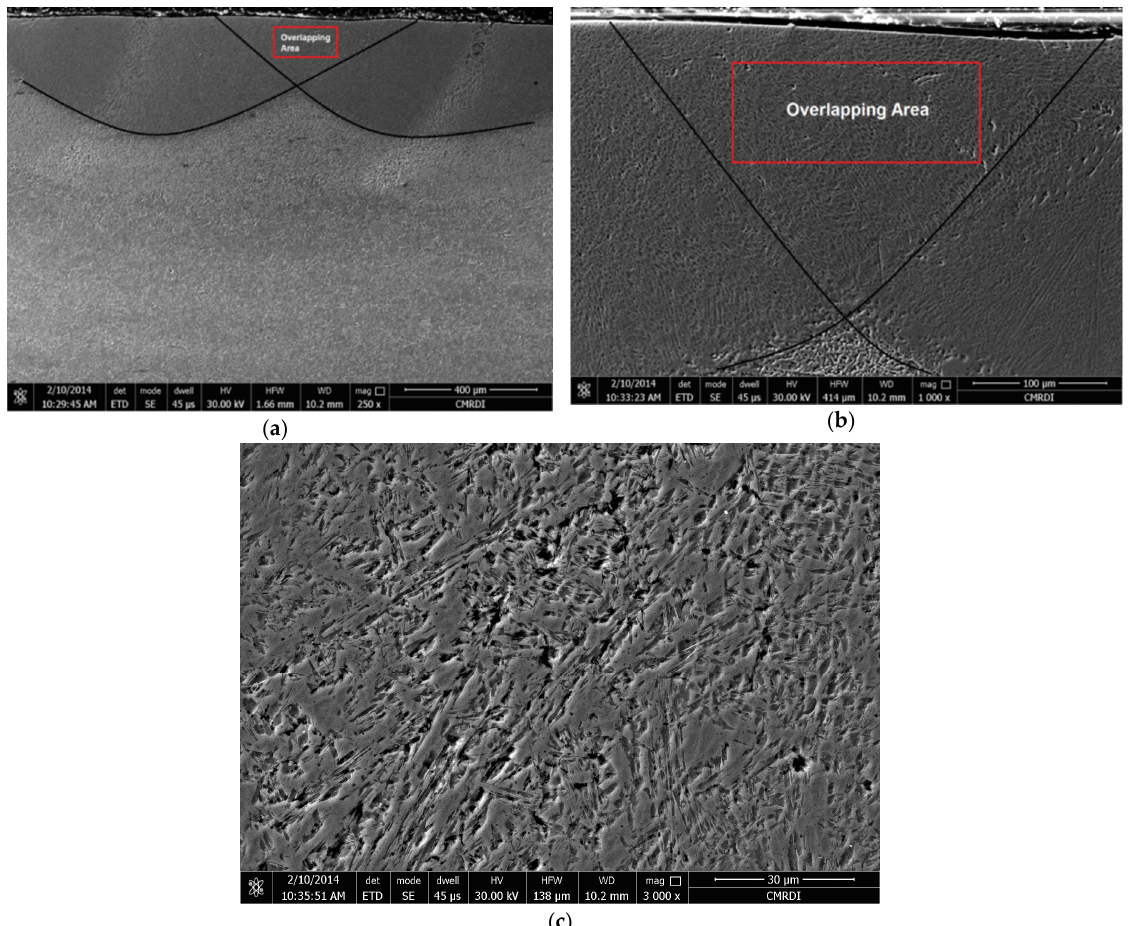
Figure 8. SEM microstructure (magnification 1000×): ( a ) HZ; ( b ) HAZ of sample P ‐ 07 ‐ 0.5 and ( c ) HZ; ( d ) HAZ of sample P ‐ 1 ‐ 0.5.